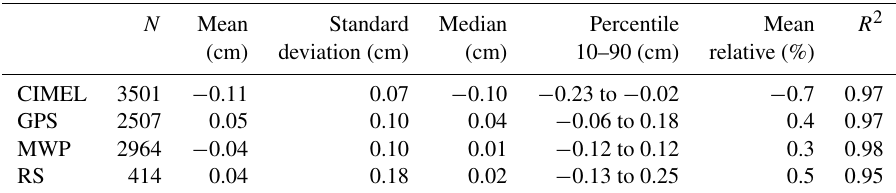
Table 2. Statistics of differences among retrievals from PSR using the spectral approach in a 934–948nm window and retrievals from other instruments for the whole data set.